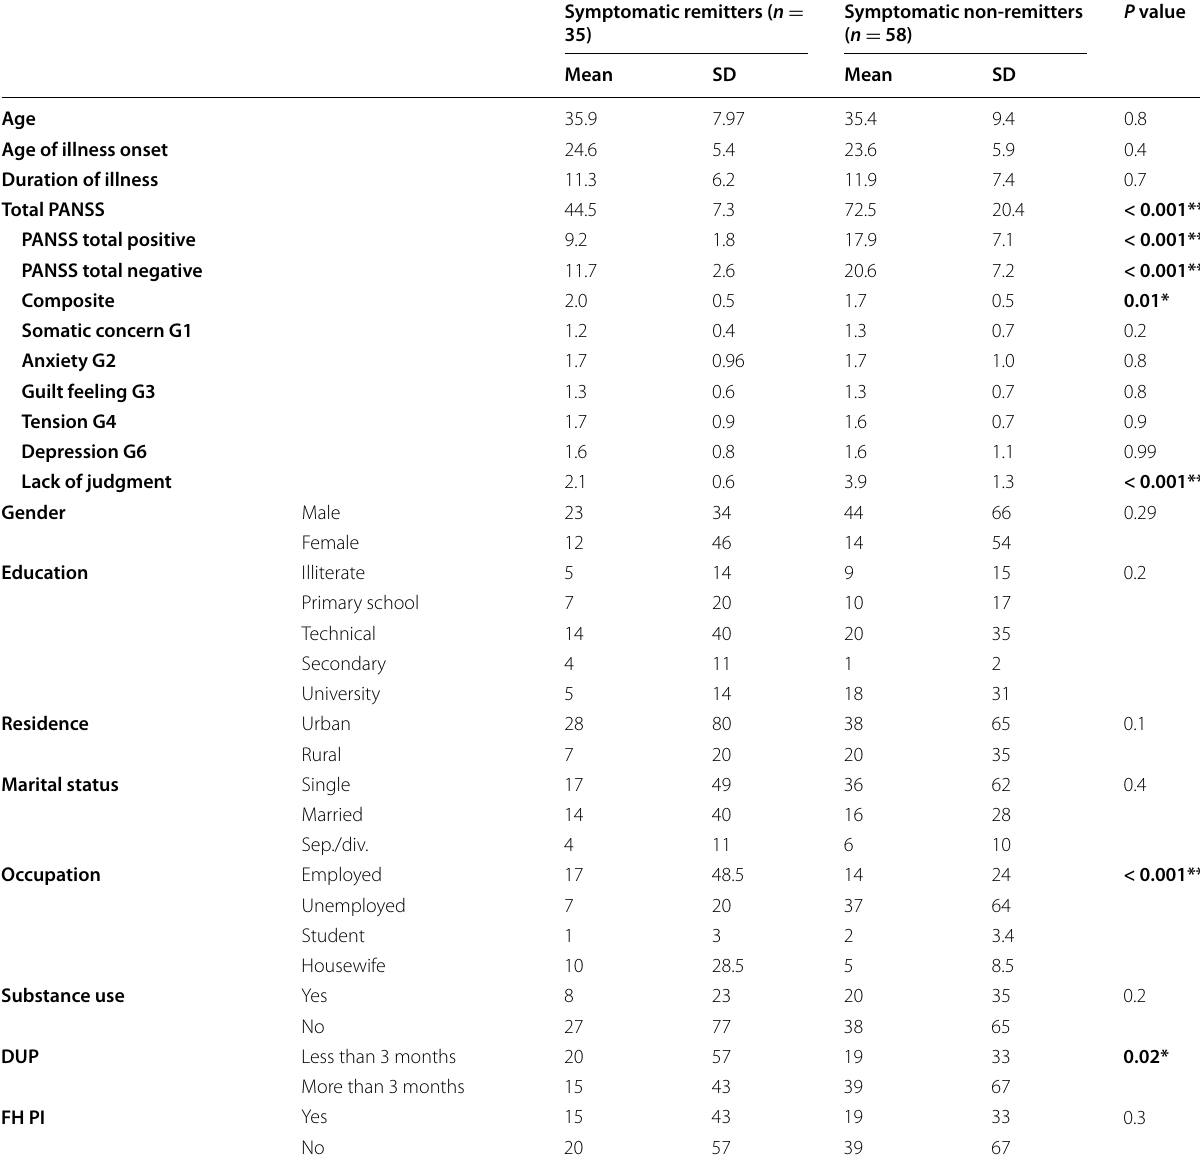
Table 1 Socio-demographic characteristics and clinical findings of both